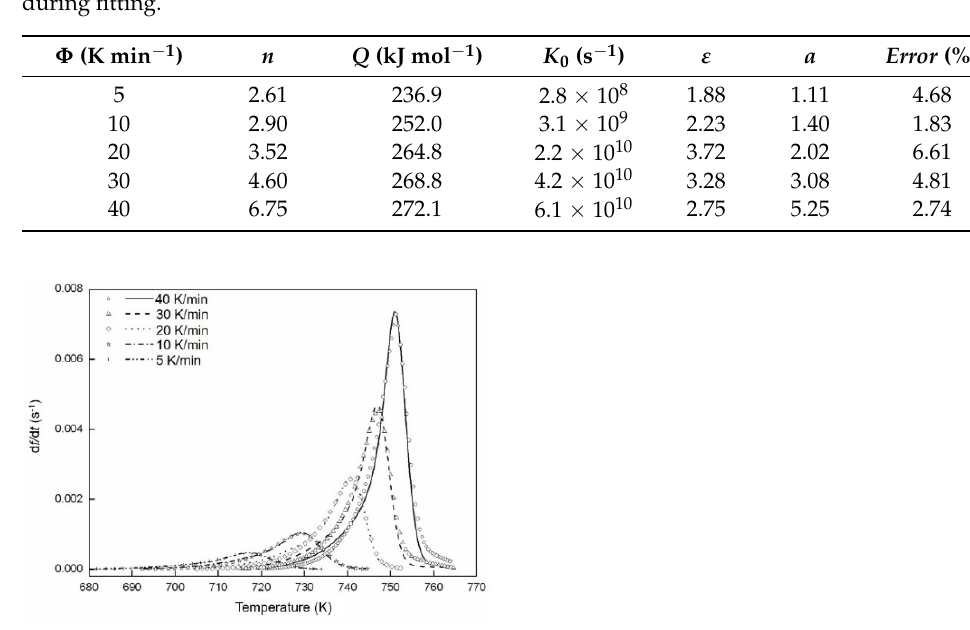
Figure 5. The transformation rate due to isochronal crystallization of amorphous Fe 85 B 15 alloy at the heating rates indicated, as measured by DSC (lines), and as fitted by the current model (symbols). The fitting result from Equation (7) of heating rates 5, 10, 20, 30 and 40 K min − 1 . The fitting parameters obtained are given in Table 1.